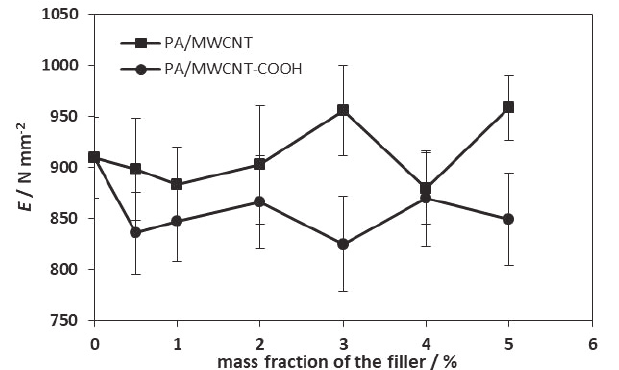
Fig. 11 – Influence of mass fraction of filler on modulus of PA/MWCNT and PA/MWCNT-COOH nanocom- posites